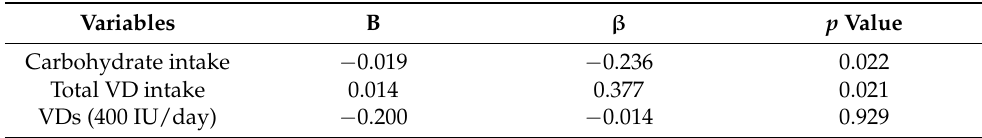
Values are means ± standard deviation or number (%). Abbreviations: VD, vitamin D; BMI, body mass index. a = no VD supplementation group, b = VD supplementation 150 IU/d group, c = VD supplementation 300 IU/d group, d = VD supplementation 400 IU/d group. Table 5. Multiple linear regression analysis of predictive factors for 25(OH)D levels in subjects with ≥ 300 g/day carbohydrate